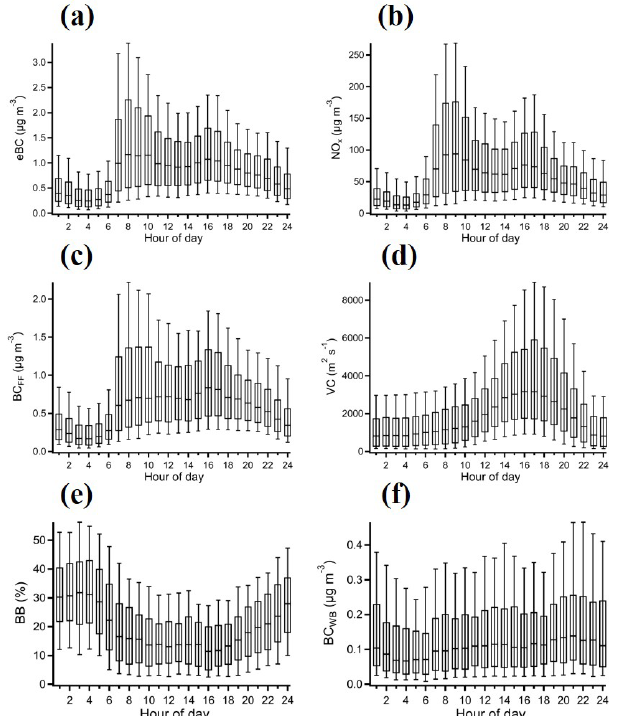
Figure 6. Diurnal variation in eBC, NO x , BC FF , VC, BB, and BC WB . In each box, the mid-line shows the median value for each x value, the whisker bottom and top correspond to the 10th and 90th percentiles, and the box top and bottom correspond to the 75th and 25th percentiles, respectively. Note that BB and BC WB diurnal variations include only winter months (December–February).